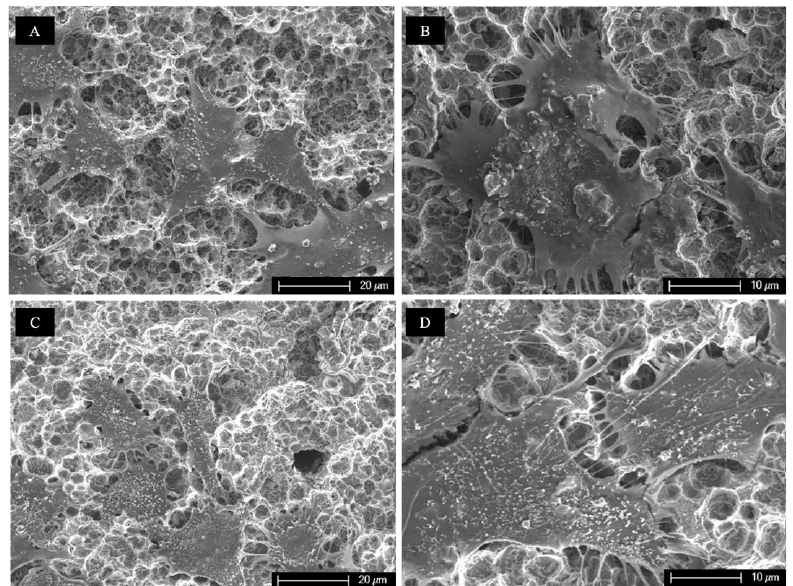
Figure 8. Representative scanning electron microscopy images of fibroblasts on microstructured titanium discs after 4 h of cultivation. ( A , B ) Plasma-treated samples. ( C , D ) Controls without plasma treatment. Fibroblasts show intensive intercellular contacts and attachment to the titanium, suggesting favorable conditions for cell–surface